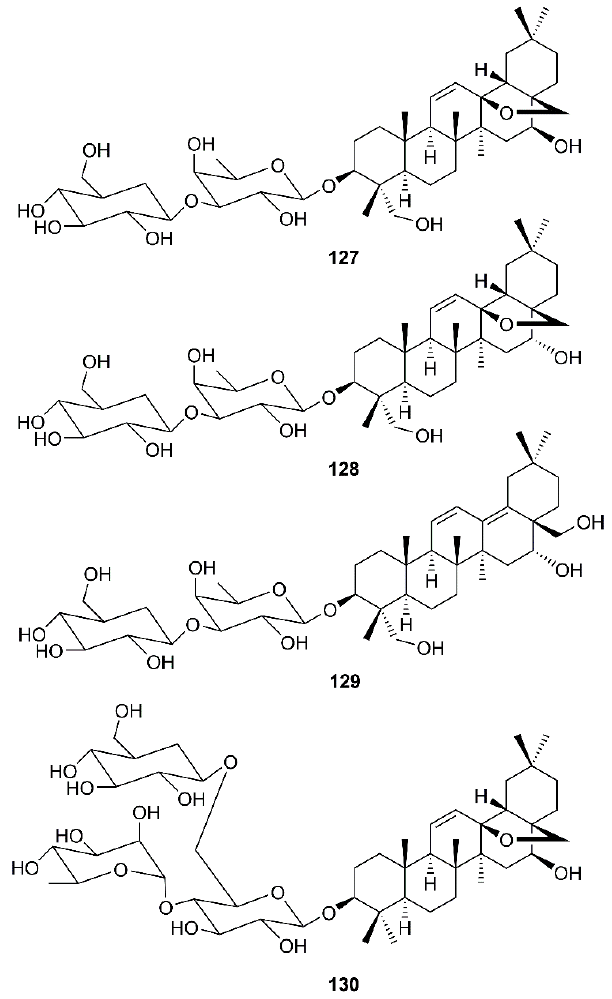
Figure 19. Structures of saikosaponins 127 – 130 .